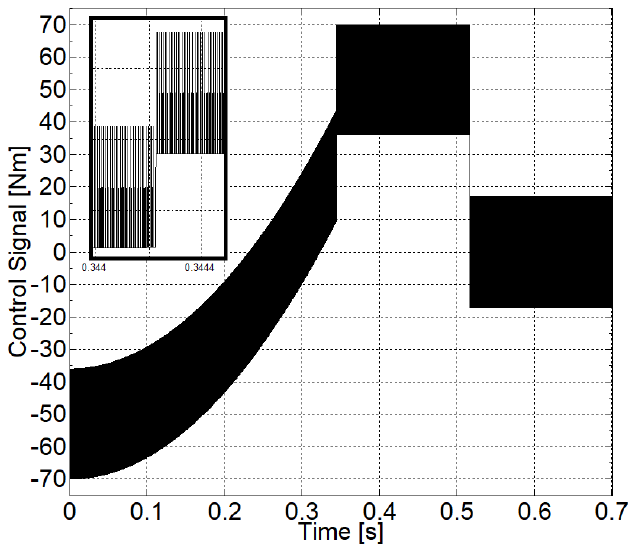
Figure 2. Control signal with the input